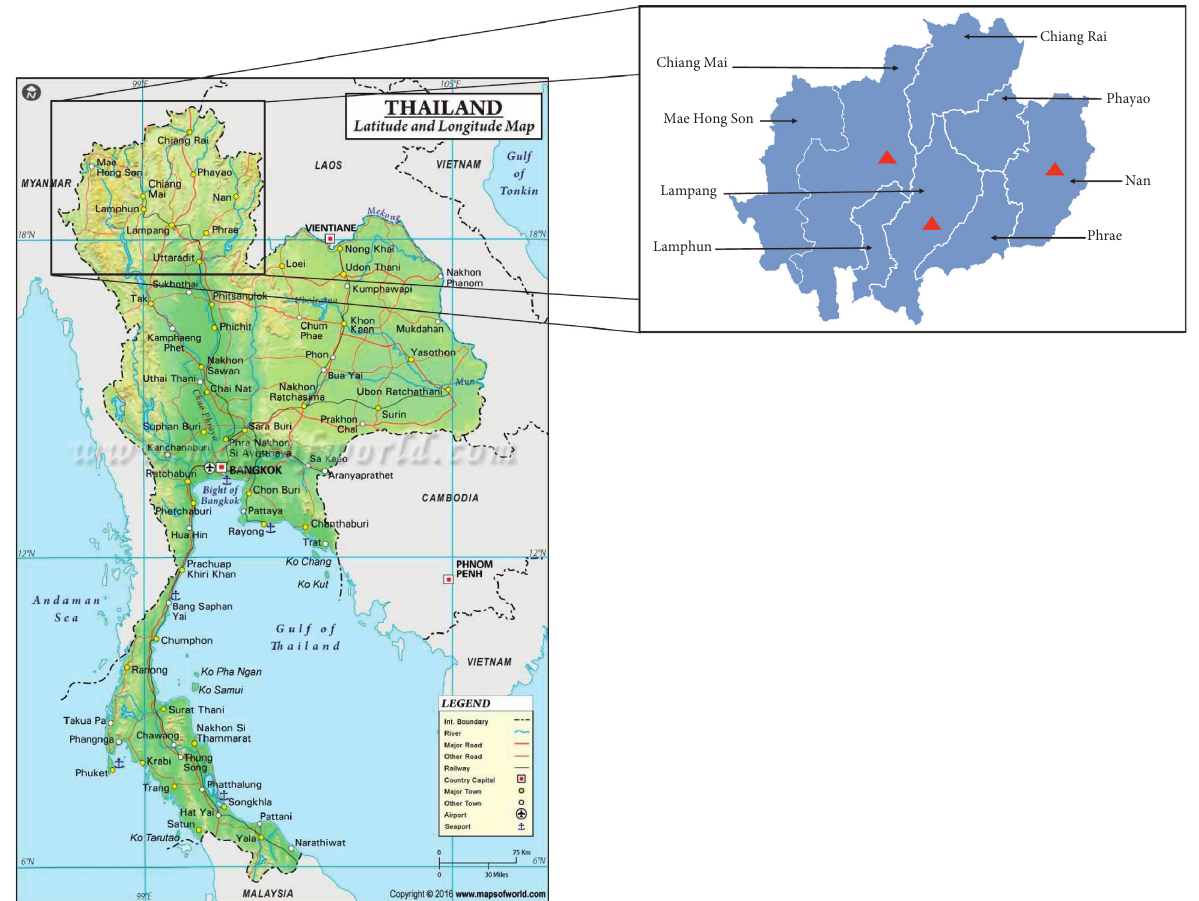
Figure 1: Map of Thailand; highlighted region shows the location of PM Table 1: Descriptive statistics and summary of PM